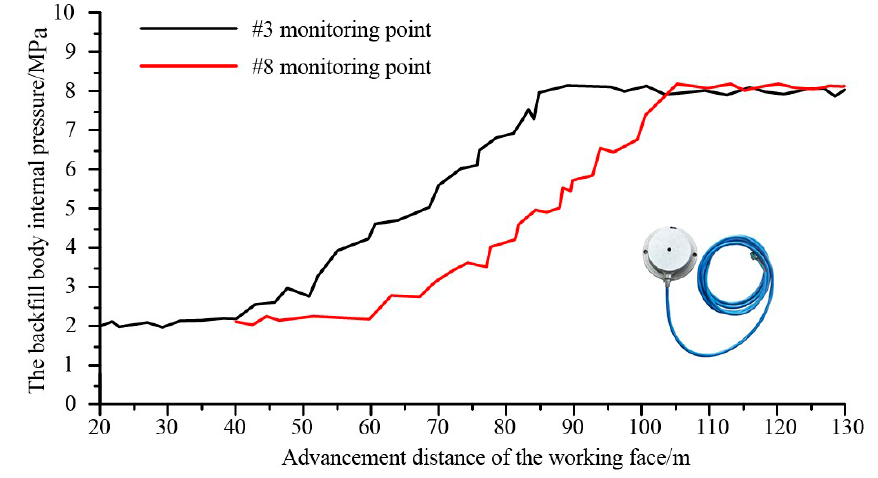
Figure 21. The curves of backfill body internal pressure of monitoring points #3 and #8.